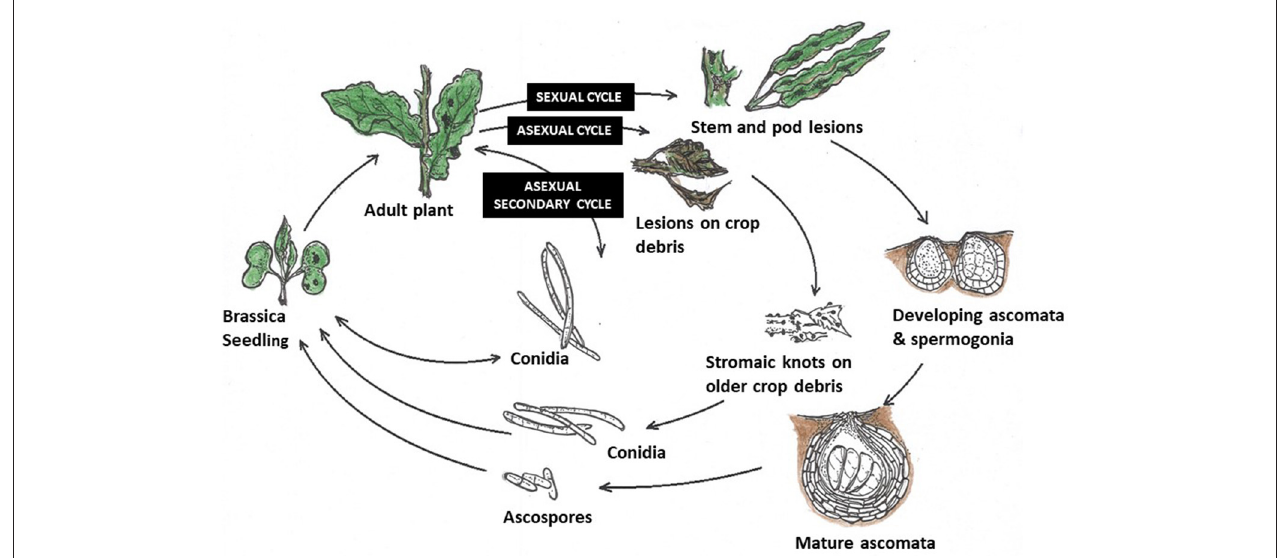
FIGURE 5 | Life cycles of Neopseudocercosporella capsellae : (i) Sexual cycle—as found in the UK on oilseed rape (Inman et al., 1999)—Initial infection is by ascospores. The first symptoms on leaves are by contamination from air-borne ascospores produced by mature ascomata. Mature lesions on leaves then produce conidia, which are splash-dispersed and responsible for secondary infections within the crop. Sexual structures on stem and pod lesions develop and release ascospores in the following crop season. (ii) Asexual cycle—proposed life cycle for N. capsellae , without the sexual stage (initial infection is from conidia) as happens in Australia (Barbetti and Khangura, 2000), Canada (Petrie and Vanterpool, 1978) and France (Penaud, 1987). In the absence of any sexual stage, carryover to initiate new epidemics is likely from splash-dispersed conidia produced by infested crop residues. (iii) Secondary cycle - secondary disease spread within and between crops is reliant upon splash-dispersed conidia produced on mature leaf lesions initiated by either ascospores or conidia.